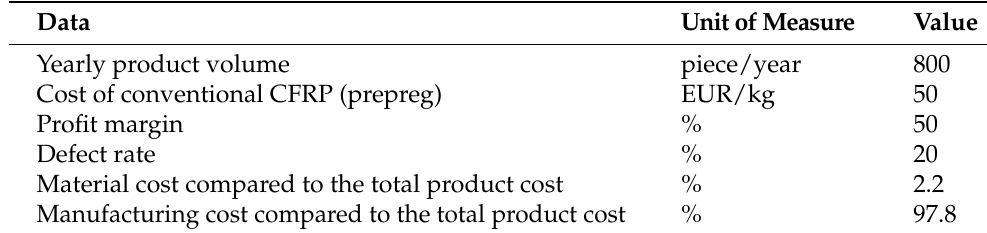
Table 10. Input data of manufacturing cost of the paddle